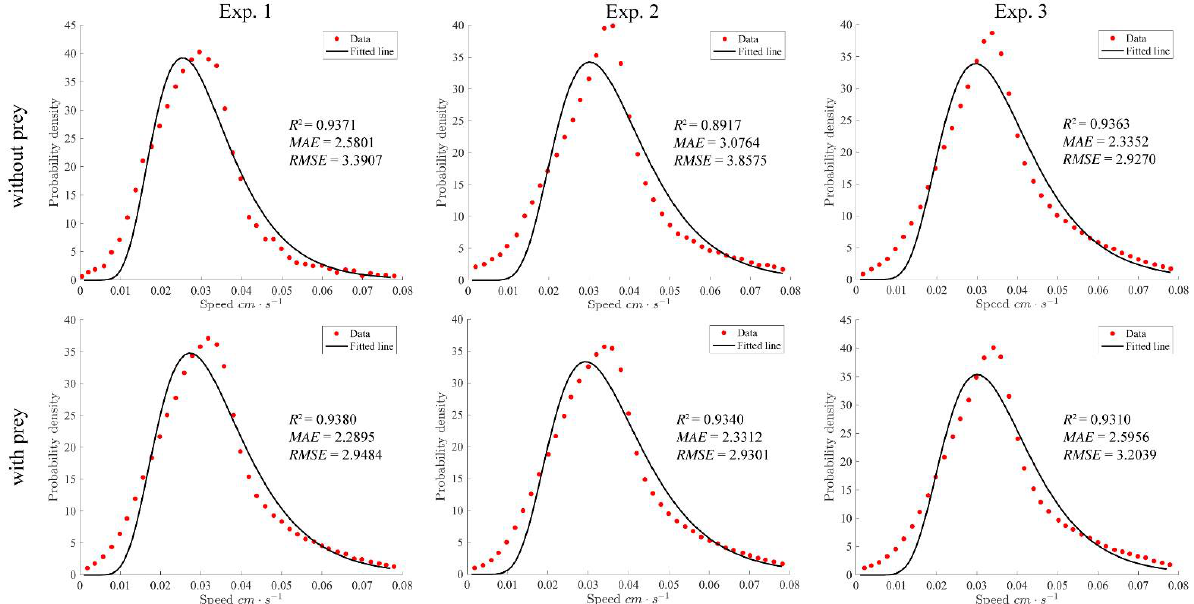
Figure 3. Fat tails in the frequency distributions of swimming speeds of O. marina before ( top ) and after ( bottom ) the introduction of a prey layer (Exp. 1 with either direct addition of the prey alga; Exp. 2&3 with cell-free filtrate) The red dots: original data; black line: fitted curve using log-normal distribution formula.